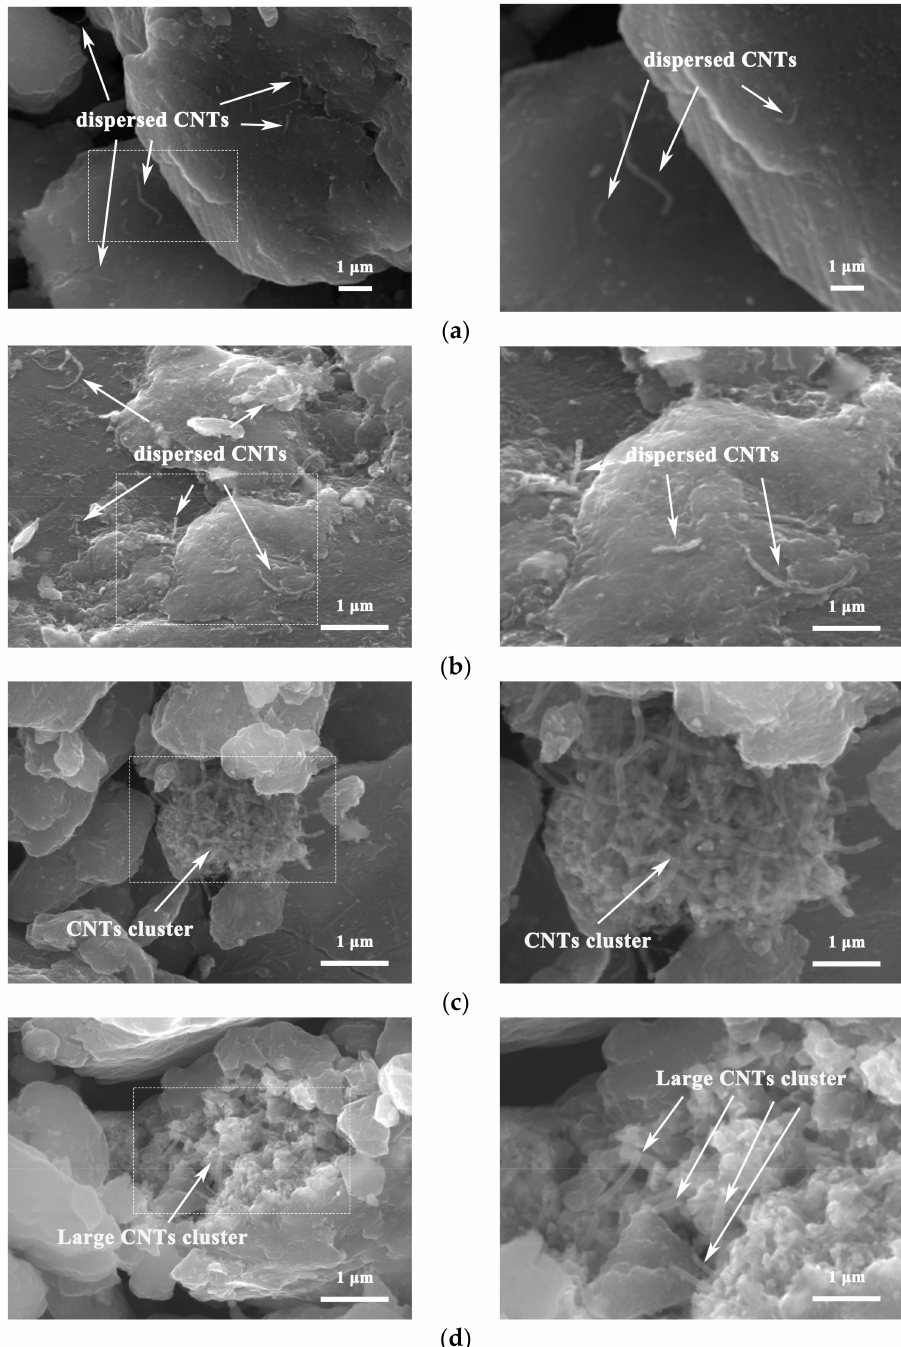
Figure 3. SEM morphology of CNTs/refined-AZ61 composite powder dispersed by ball milling under different contents of CNT. ( a ) 0.5%, ( b ) 1%, ( c ) 1.5%, ( d )